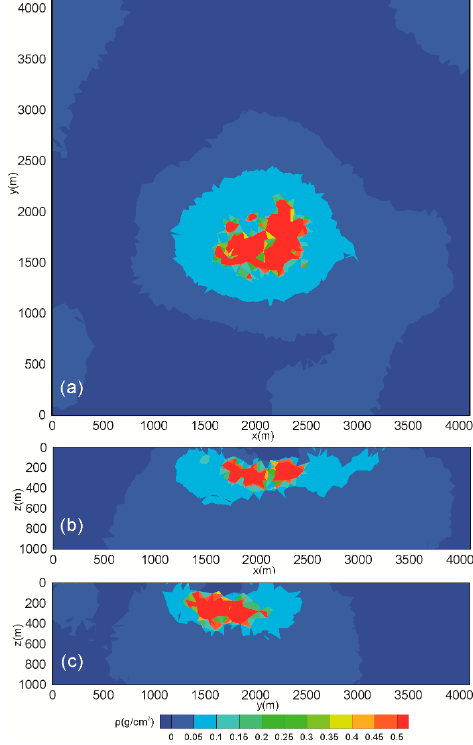
Figure 10. FCM clustering inversion result of Vinton Dome on ( a ) x-y-plane at z = 0.3 km; ( b ) x-z-plane at y = 1.7 km; ( c ) y-z-plane at x = 2.2 km.